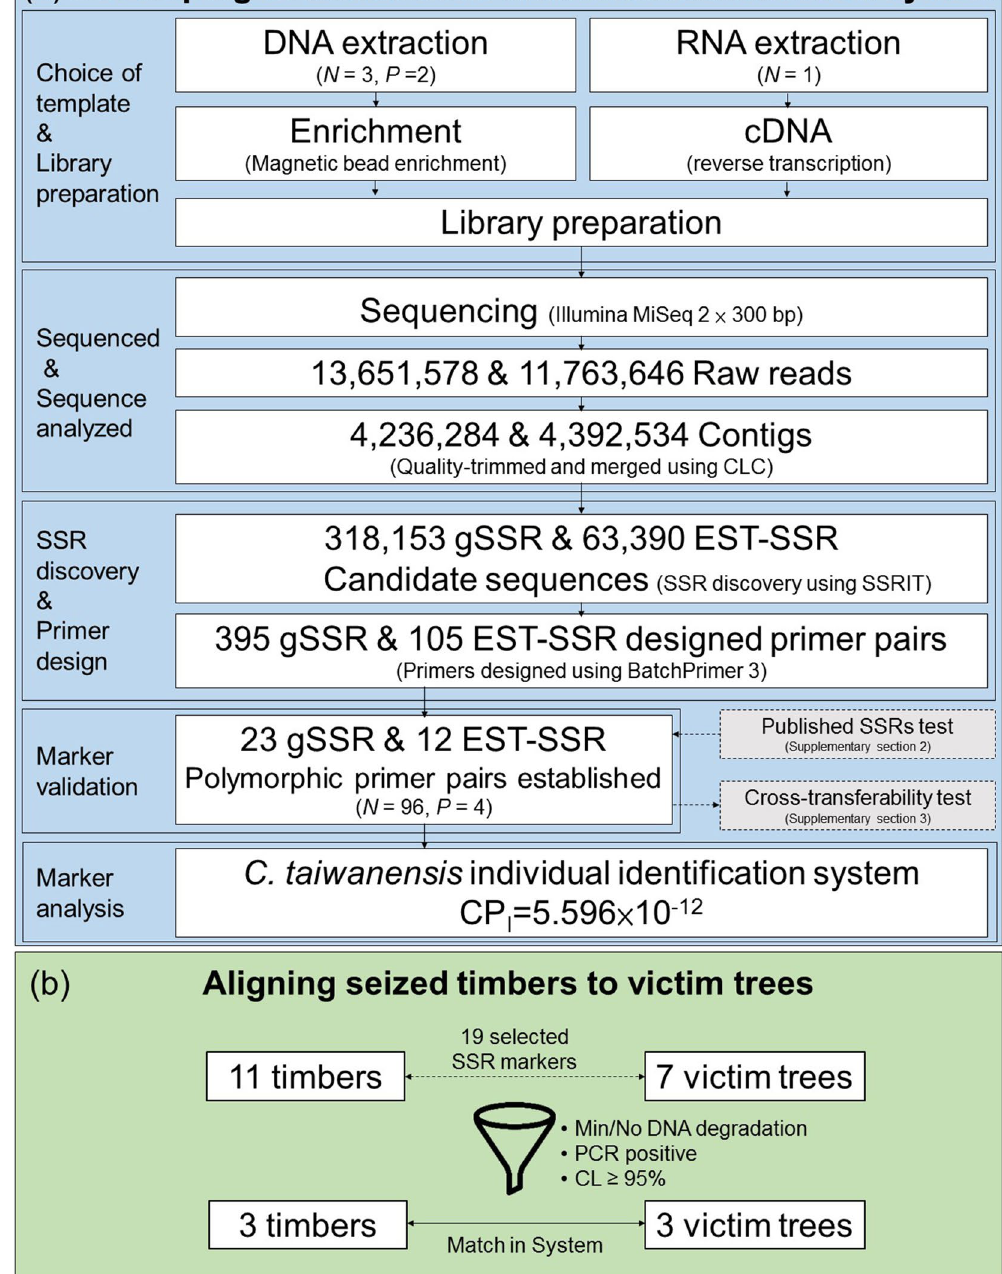
Figure 1. Flowchart describing the procedure of developing SSR markers and aligning illegally-felled timbers to victim trees of C. taiwanensis . ( a ) 35 SSR markers specific to individual identification were selected from the DNA and RNA libraries of C. taiwanensis . The cumulative random matching rate of the system reaches CP I = 5.596 × 10 –12 , which can be used to identify 18 million individuals with a credibility of 99.99% ( b ) 11 seized timbers were compared with 7 victim trees, and 3 timbers were matched with 3 victim trees successfully. The values of credibility in all matched cases were over 95%. ( N number of individuals, P number of